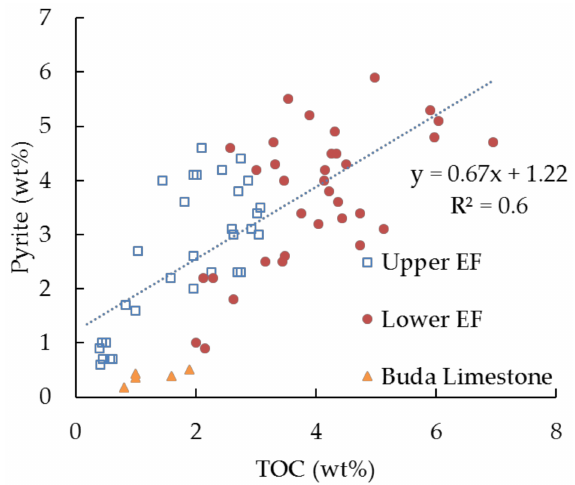
Figure 5. Positive linear relationship between pyrite and TOC in the Eagle Ford Shale.